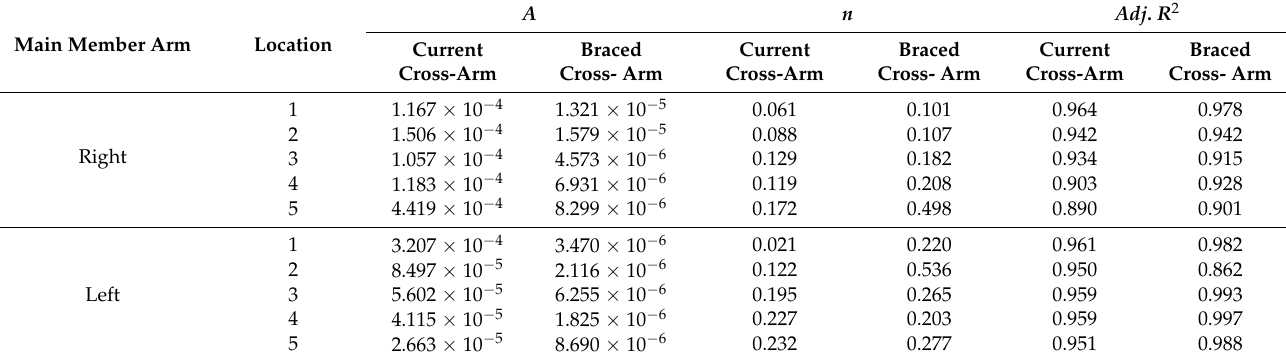
Table 1. A parameter and stress independent material exponent, n from Findley power law for current and braced PGFRPC cross-arms.